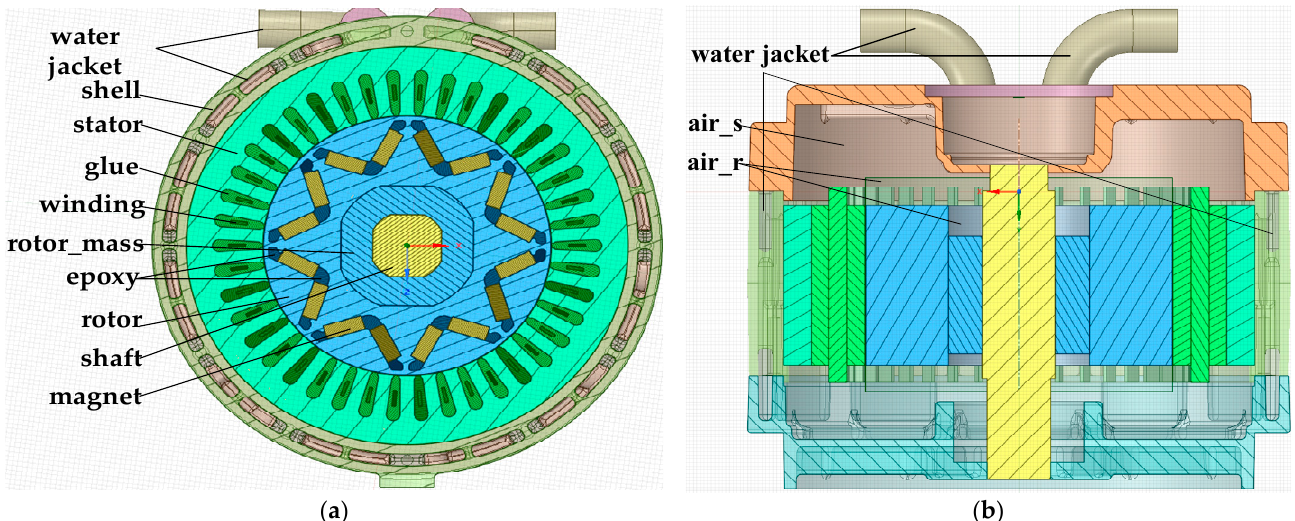
Figure 1. Structure of the PMSM. ( a ) Cross-section; ( b ) longitudinal section.